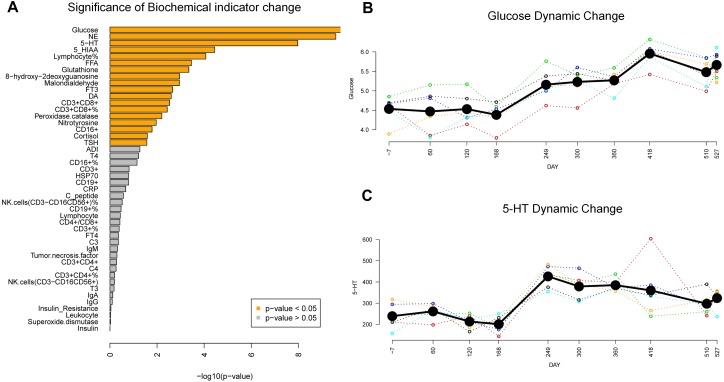
Biochemical changes in the MARS500 mission. (A) Significance of Biochemical indicator change during the mission. 18 indicators (orange bar) significantly changed (P < 0.05, ANOVA). (B) Glucose dynamic change pattern during the mission. Bold black line: mean value of subjects at each sampling points. Colored dash line, glucose trend for each subject. (C) 5-HT dynamic change pattern during the mission. Bold black line: mean value of subjects at each sampling points. Colored dash line, 5-HT trend for each subject.